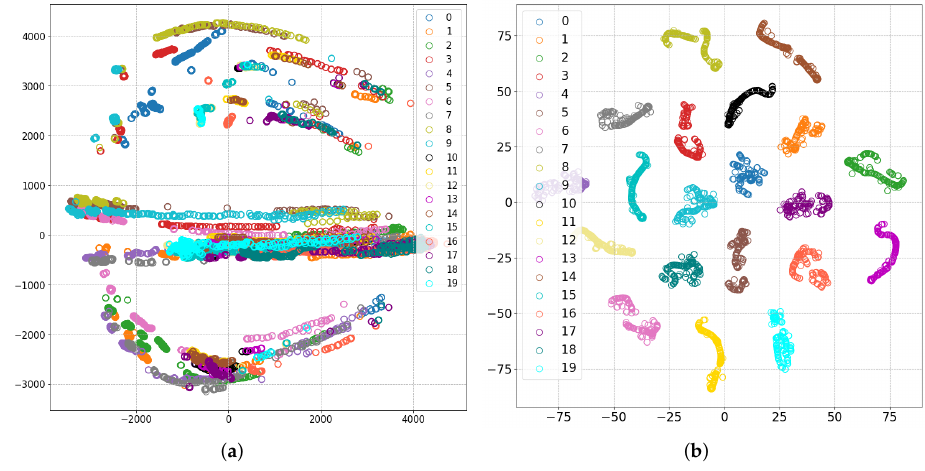
Figure 8. Visualization of data using t-distributed stochastic neighbor embedding (t-SNE) algorithm ( a ) with input data ( b ) with feature vector of last hidden layer in CNN model.